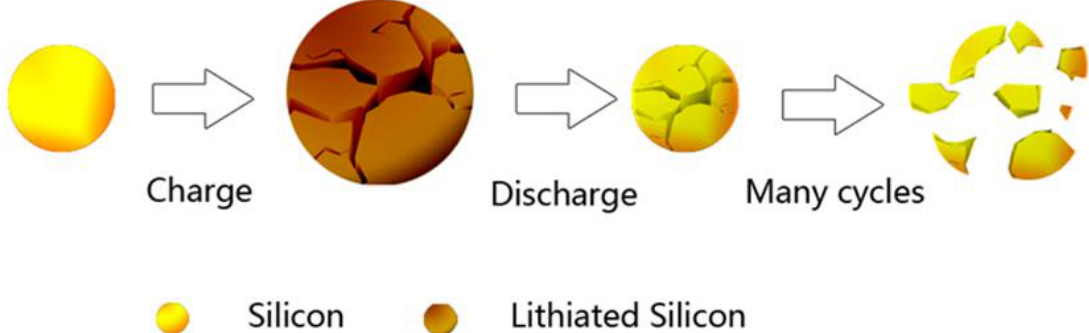
Figure 1. Schematic diagram of silicon anode material cracking during charge-discharge cycles. The volumetric effect of the silicon-lithium alloy results in high mechanical strain, which causes the silicon anode material to rupture.